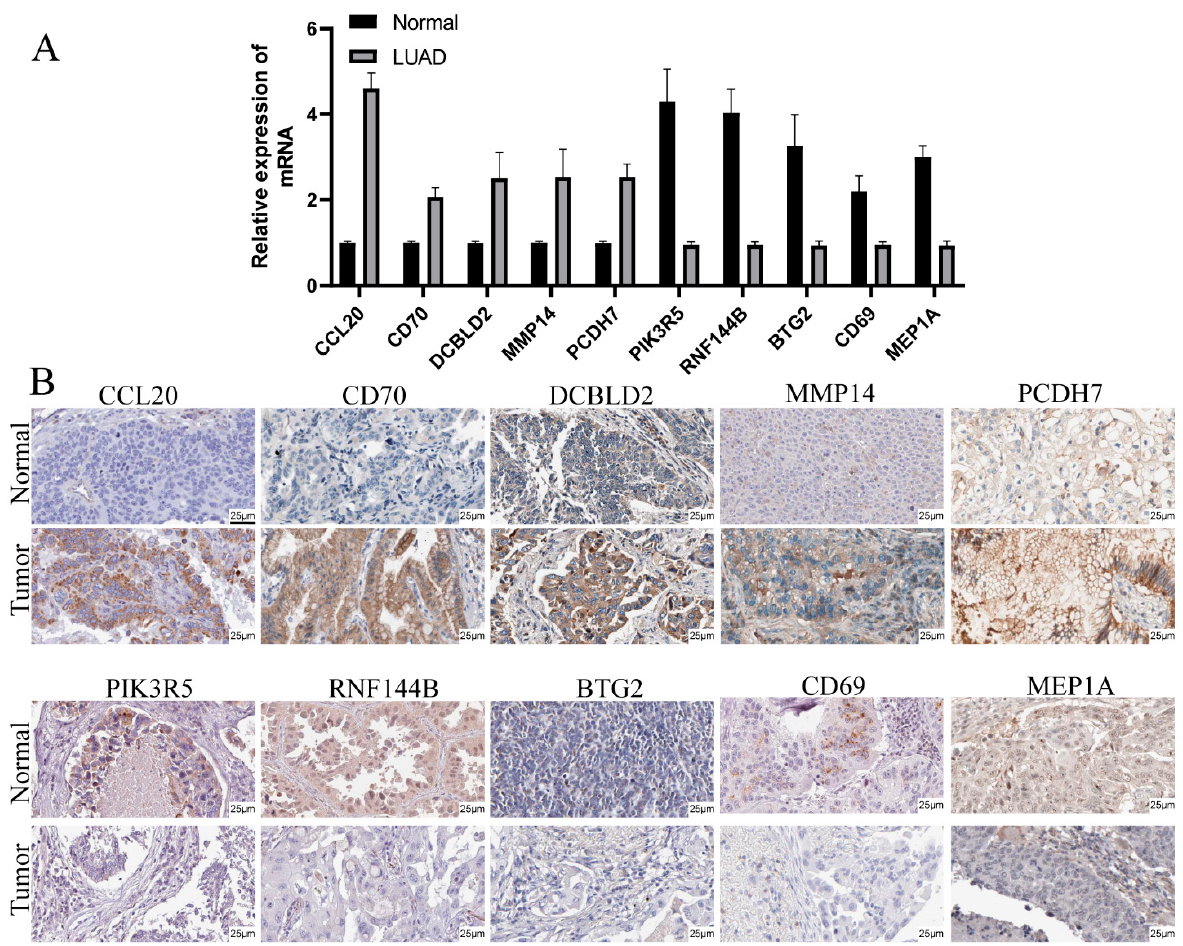
Figure 9. Prognostic gene protein and mRNA levels in LUAD compared with healthy samples. ( A ) mRNA levels were analyzed through qRT-RCR. ( B ) Protein levels were analyzed through IHC.